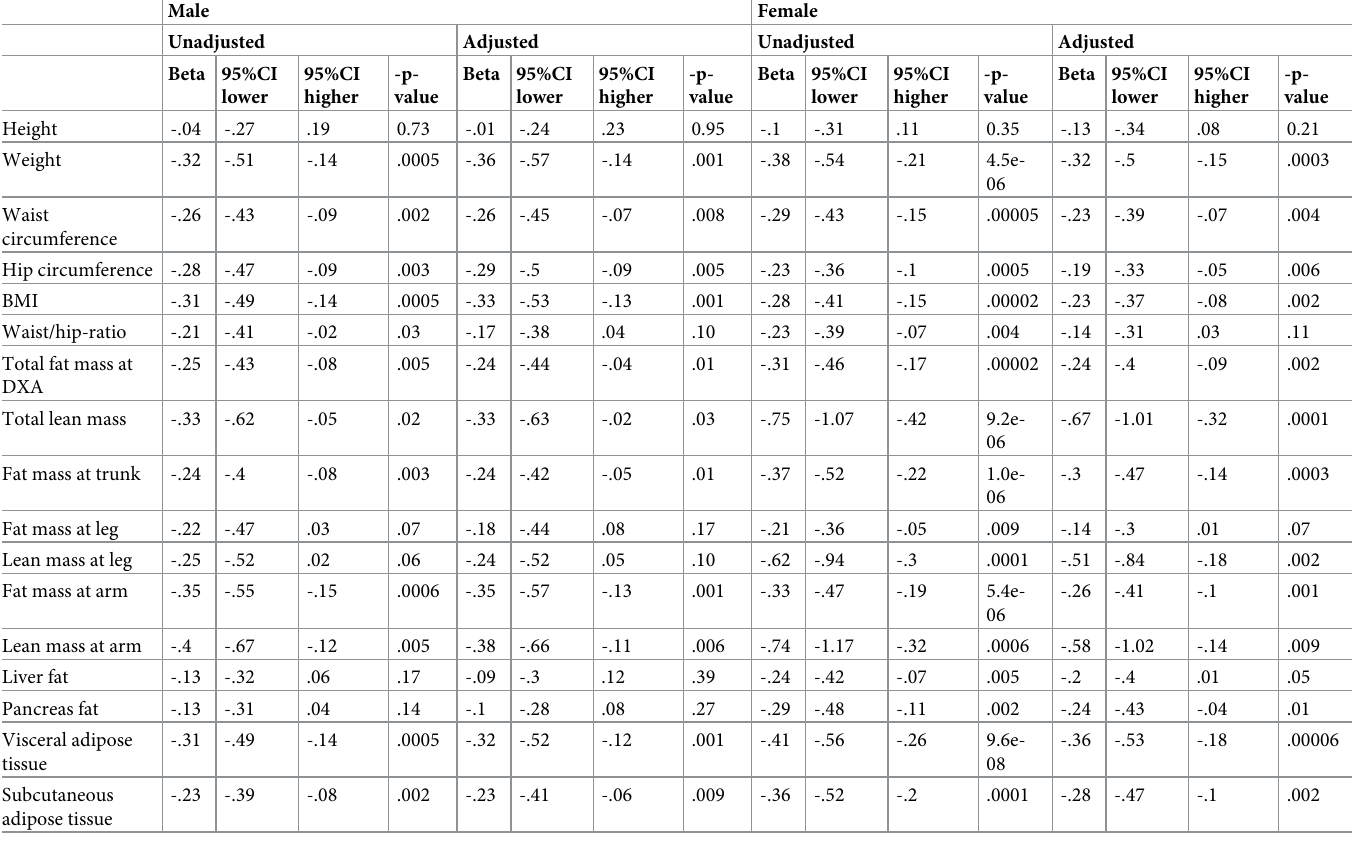
Table 3. Relationships between echogenicity of the intima-media complex (IM-GSM) and traditional measurements of body composition. Male Female Unadjusted Adjusted Unadjusted Adjusted Beta 95%CI